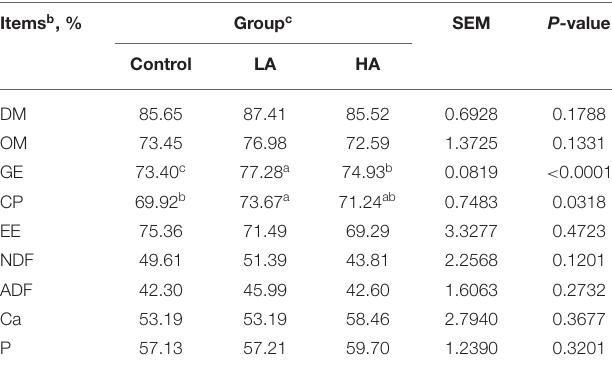
TABLE 2 | Effect of purple corn anthocyanin on apparent digestibility of dairy goats a .